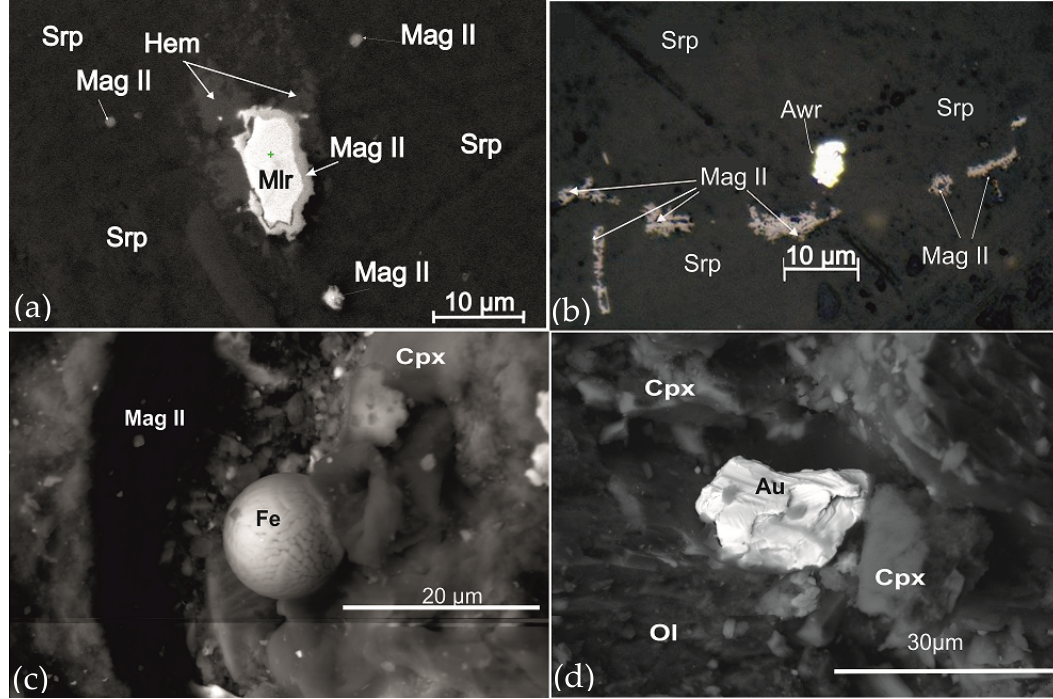
Figure 10. Backscatter electron images of ( a ) a millerite (Mlr) grain with a rim of magnetite II, ( b ) Awaruite (Awr) associated with magnetite II in the serpentinite (Srp) (sample 3 / 7, Burlakski pluton, ( c ) “spheroidal” native iron (Fe) and ( d ) native gold in serpentinite (Srp) of the N-D pluton (sample 8 / 4). Cb,